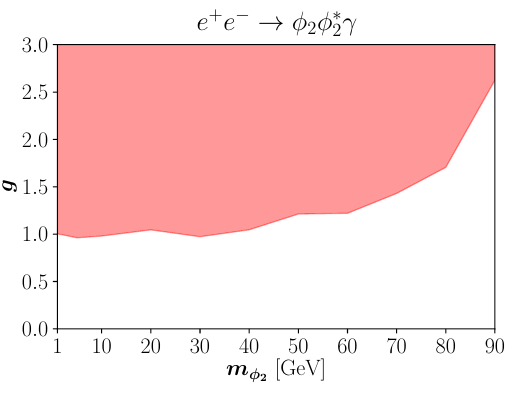
Figure 12 . Exclusion limits at 95% CL for the process e + e (cid:0)